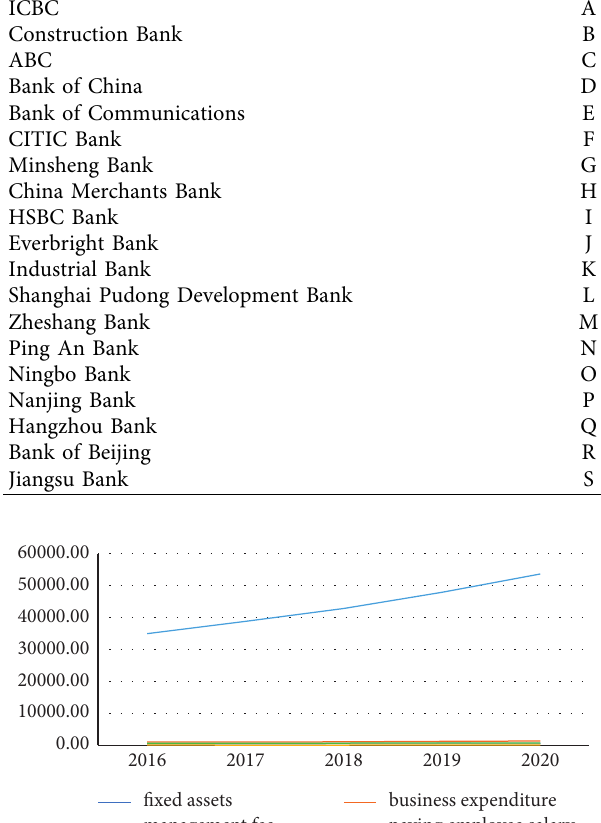
Figure 1: Diagram of the relationship between input and output indexes. Table 1: Surrogate names of